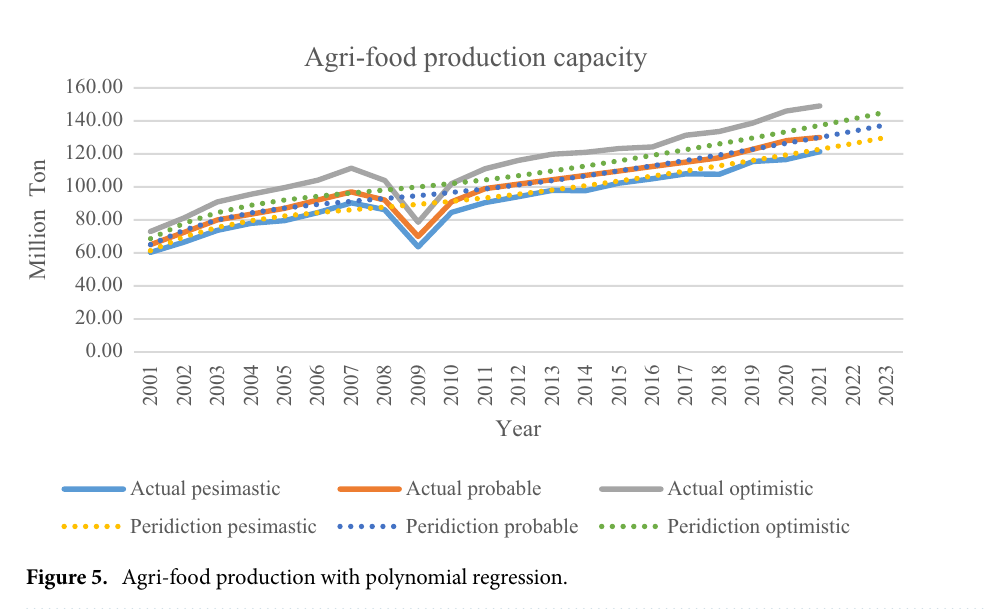
Figure 5. Agri-food production with polynomial regression.